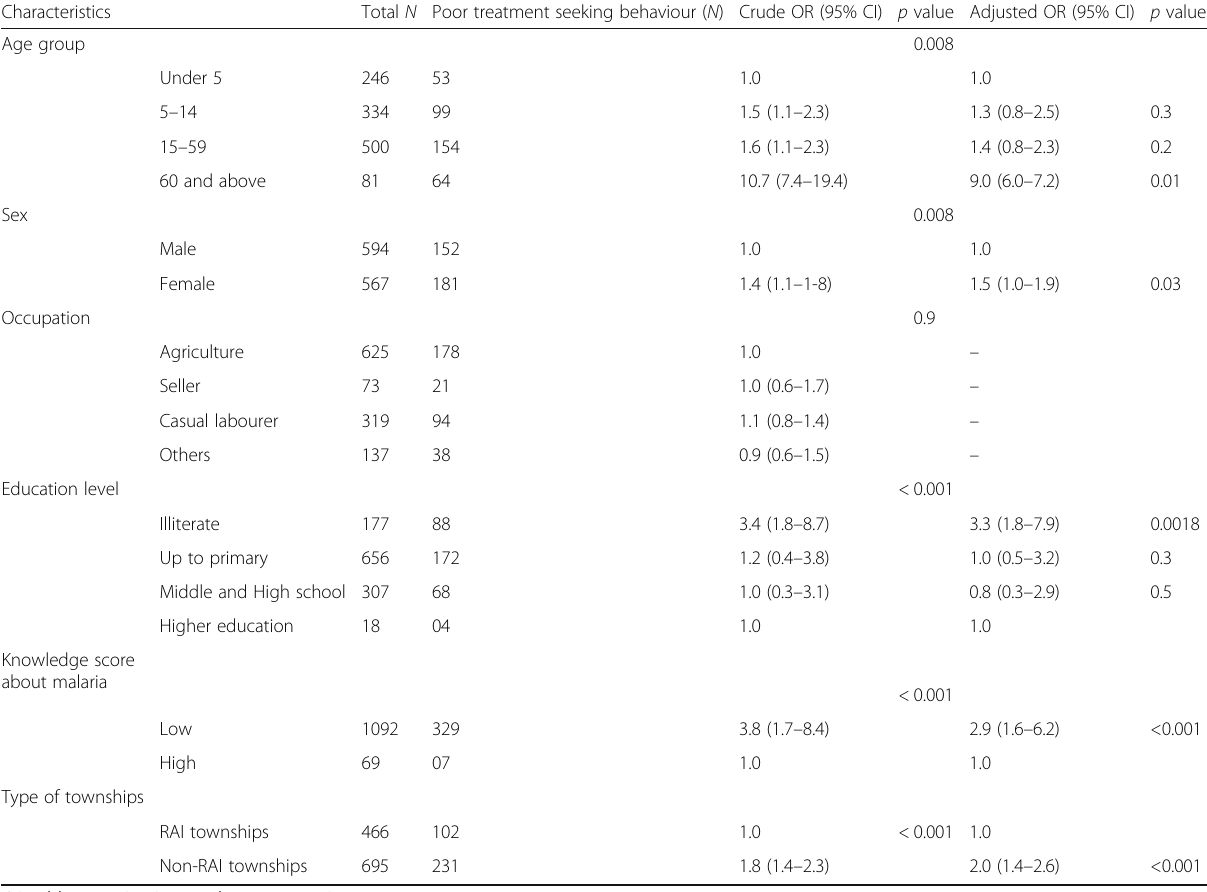
Table 3 Association of socio-demographic characteristics of respondents with poor treatment-seeking behaviour of those who re- ported fever within the last 2 weeks in the endemic regions of Myanmar, 2015